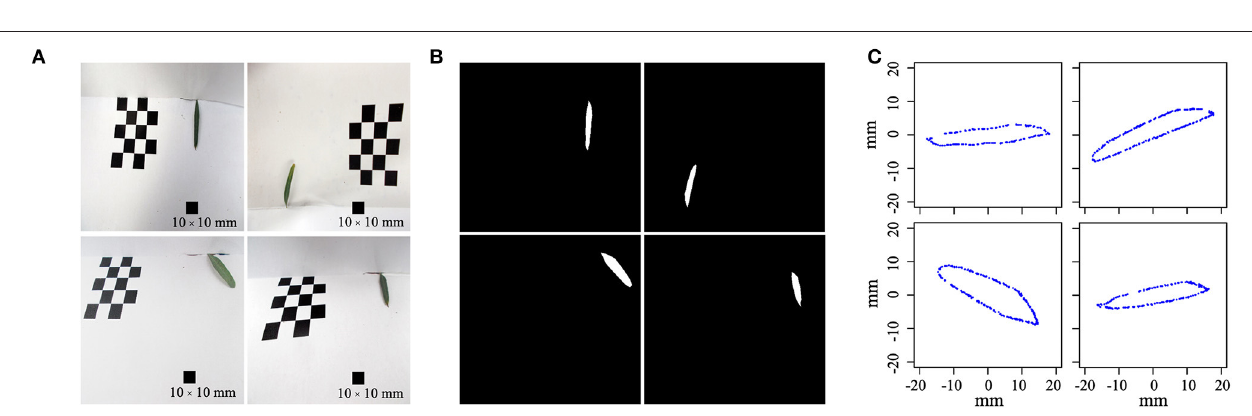
FIGURE 2 | Diagram of the leaf shape reconstruction process. (A) Four original leaf images were randomly selected from a batch of images; each image was taken from a random angle. (B) Leaves were binarized on the raw image using the pixel coordinates of a fixed leaf. (C) Reconstructed leaf shapes, with two-dimensional coordinates along the leaf boundary, were calculated to reflect the size and morphology of the original